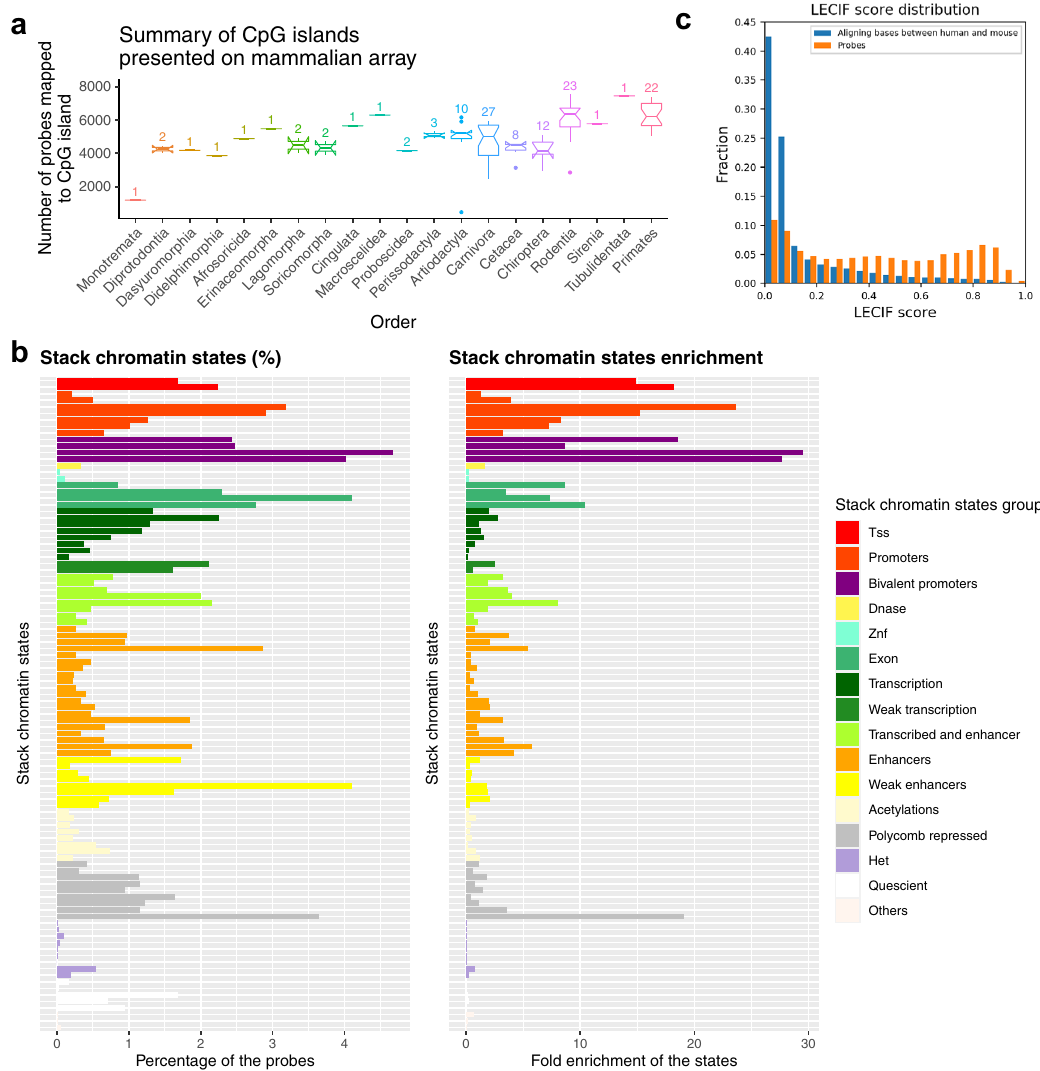
Fig. 3 CpG island and chromatin state analysis of mammalian methylation probes. We characterize the CpGs located on the mammalian methylation array regarding a CpG island status in different phylogenetic orders, b chromatin state analysis, and c Learning Evidence of Conservation from Integrated Functional genomic annotations (LECIF) score of evidence of human-mouse conservation at the functional genomics level 26 . a Each boxplot depicts the median number of CpGs that map to CpG islands in mammalian species of a given phylogenetic order ( x axis). The lower and upper bound of each box visualizes the lower and upper quartile of the distribution. The notch around the median number of CpGs (horizontal line inside box) depicts the 95% con fi dence interval. The whiskers extend to the most extreme data point, that is, no more than 1.5 times the interquartile range from the box. The numbers above each box report the number of analyzed species in each order, e.g., n = 22 primate species. b Mammalian methylation array enrichment for universal chromatin state annotations. (Left) Distribution of probe overlap with a universal chromatin state annotation by the stacked modeling approach of ChromHMM applied to data from more than 100 cell or tissue types 19 . Bars are colored based on their state corresponding state group as indicated by the legend on right. (Right) The same as left, but showing the fold enrichments of the state relative to a uniform background. The strongest enrichment is seen for some bivalent promoter states. A version of the fi gure with individual states labeled can be found in Supplementary Fig. 6. TSS, transcriptional start site; DNase, DNase I hypersensitivity; znf, zinc fi nger genes; Het, heterochromatin. c Comparison of distribution of LECIF score for probes on the array (orange) and aligning bases between human and mouse (blue). The LECIF score has been binned as shown on the x axis, and the fraction of probes or aligning bases with scores in that bin are shown on the y Comparison with the human EPIC methylation array study in and rat ( n = 10). The same engineered DNA methylation samples calibration data . We compared the mammalian methyla- were analyzed on the human EPIC array as on the mammalian tion array to the human EPIC methylation array, which pro fi les methylation array above. In particular, we were able to correlate 866k CpGs in the human genome. Some of the EPIC array probes each CpG on the EPIC array with a benchmark measure (Pro- are expected to apply to the mouse and rat genomes as well 31 . To portionMethylated) in mice and rats (Table 1). Only 2356 (out of facilitate a comparison between the mammalian methylation 866k) CpGs on the human EPIC exceed a correlation of 0.90 with array and the human EPIC array for non-human samples, we ProportionMethylated in mice. By contrast, 24,050 CpGs on the applied the latter to calibration data from mouse ( n = 15 arrays) mammalian array exceed the same correlation threshold in mice.